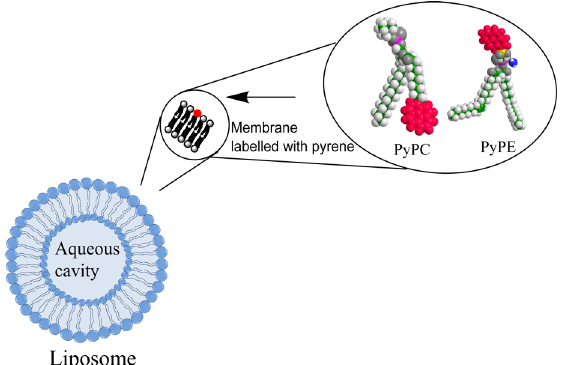
Fig 1. Schematic showing liposome containing pyrene labelled phospholipids. The expanded section depicts lipids with pyrene labelled on the fatty acid tail group (PyPC) and head group (PyPE).